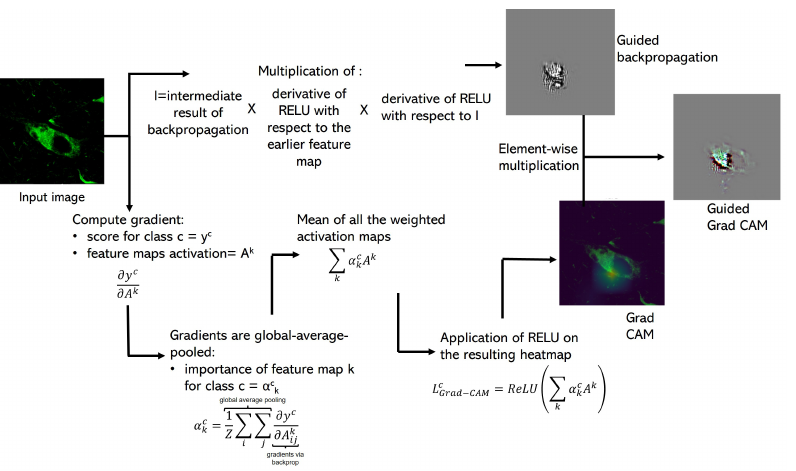
Figure 4. Guided Grad-CAM study diagram. This process has three stages. Stage one: Grad-CAM computation. The input image enters the classifier previously trained and it is forward-propagated until the last convolution layer. Here, we computed the gradients of the scoring class for the activations of the feature maps of the last convolution layer. Then, the gradients flowing back are global-average- pooled to obtain a weight of each feature map for a target class. Each activation map is multiplied by its corresponding weight and we obtain the average. Finally, we apply ReLU on the resulting visualization to keep only positive influence on the output map. Stage two: guided back-propagation computation. The input image enters the classifier previously trained and it is forward-propagated until the last convolution layer. A current intermediate result of back-propagation is multiplied